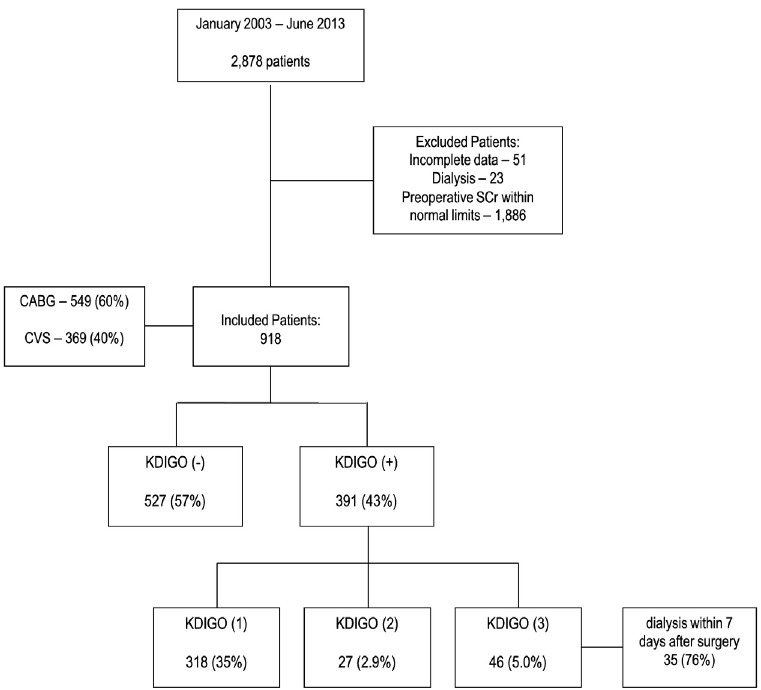
Fig. 1 - Study flow chart showing patients underwent cardiac surgery and staging for acute kidney injury (AKI) based on the KDIGO